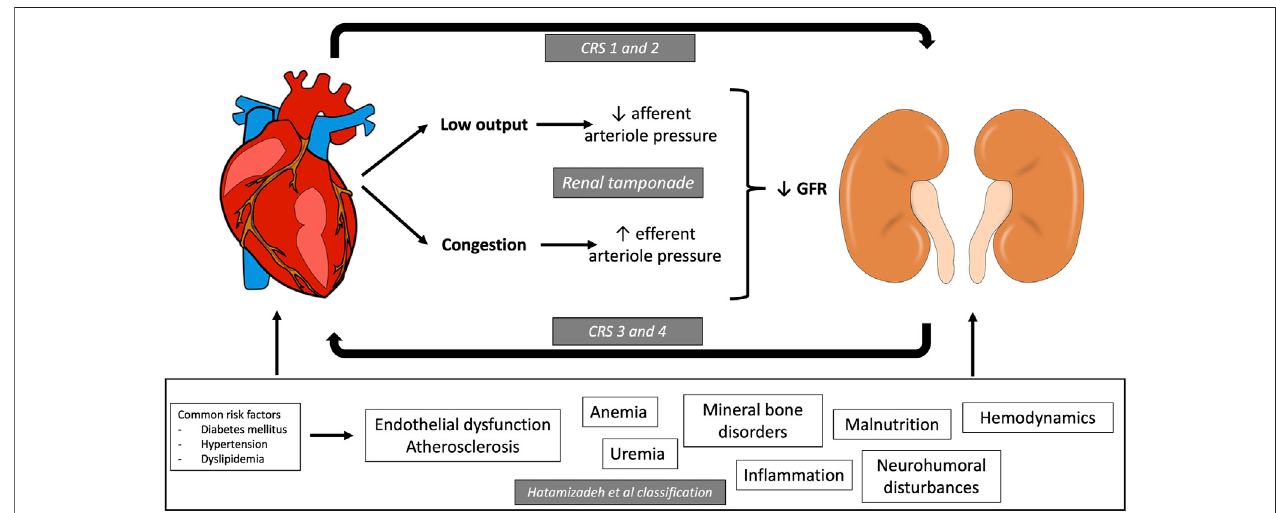
FIGURE 1 | Cardiorenal pathophysiology. Interrelation between heart and kidney in the development of the different types of cardiorenal syndrome (CRS). Type 1 and type 2 CRS are described as acute (Chioncel et al., 2017) or chronic (Mullens et al., 2019) heart failure resulting in acute kidney injury (AKI) or chronic kidney disease (CKD). Type 3 and 4 CRS are known as acute and chronic renocardiac syndrome and are described as AKI (Abraham et al., 2011) or CKD (Melenovsky et al., 2015), resulting in heart failure. Type 5 is known as secondary CRS, and it is described as a systemic process resulting in heart and kidney failure. The classi fi cation by Hatamizadeh et al. proposes seven disease categories that contribute to CRS: hemodynamic (heart failure), uremia and kidney failure, atherosclerosis, endothelial dysfunction, neurohumoral, anemia and iron disorders, mineral disorders (FGF23, phosphorus or vitamin D disorders), and in fl ammatory pathways leading to